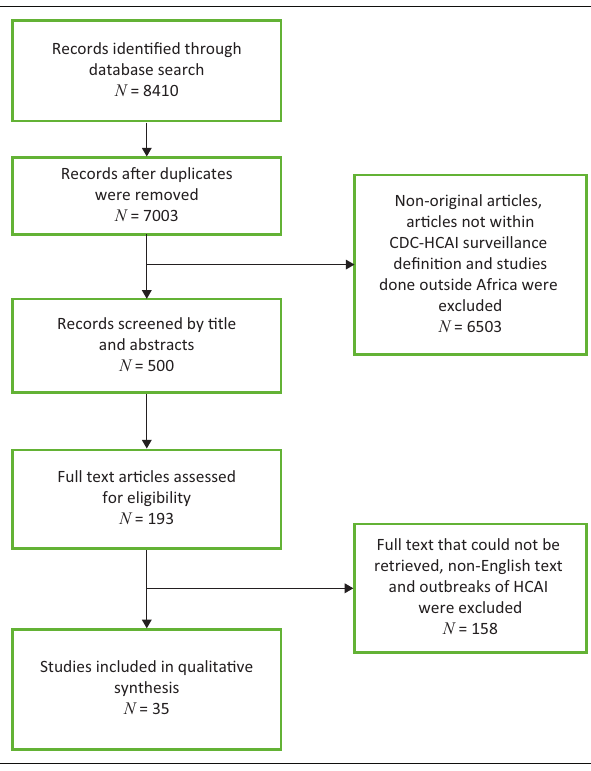
FIGURE 1: Search terms used in the systematic review.